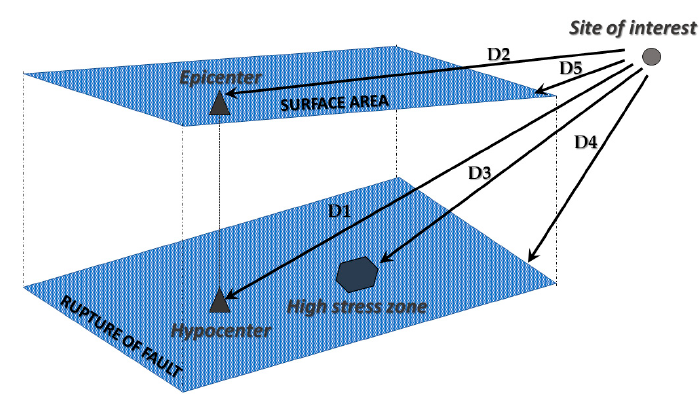
Figure 4. Distances from an earthquake source to the site of interest (adapted from Joyner and Boore (1988) [21]).